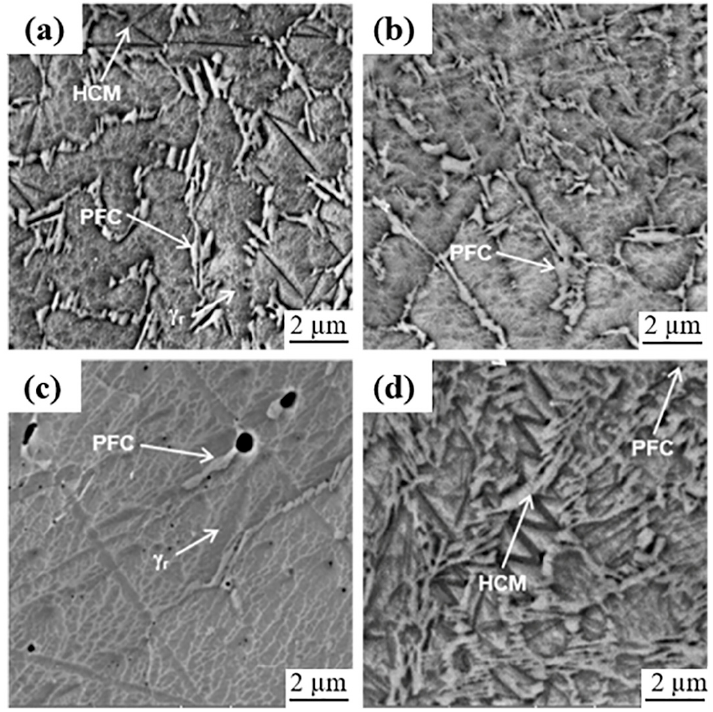
Figure 10. Melting zone (H1) microstructure 70 W (P4), ( a ) Sample 1, ( b ) Sample 2, ( c ) Sample 3, ( d ) Sample